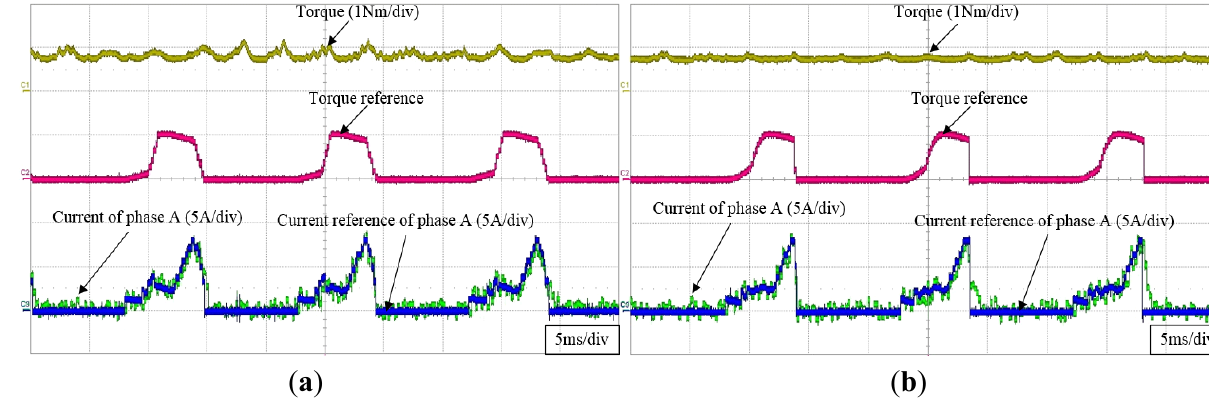
Figure 17. Experiment results at 1000 rpm: ( a ) asymmetric TSF; ( b ) non-unity